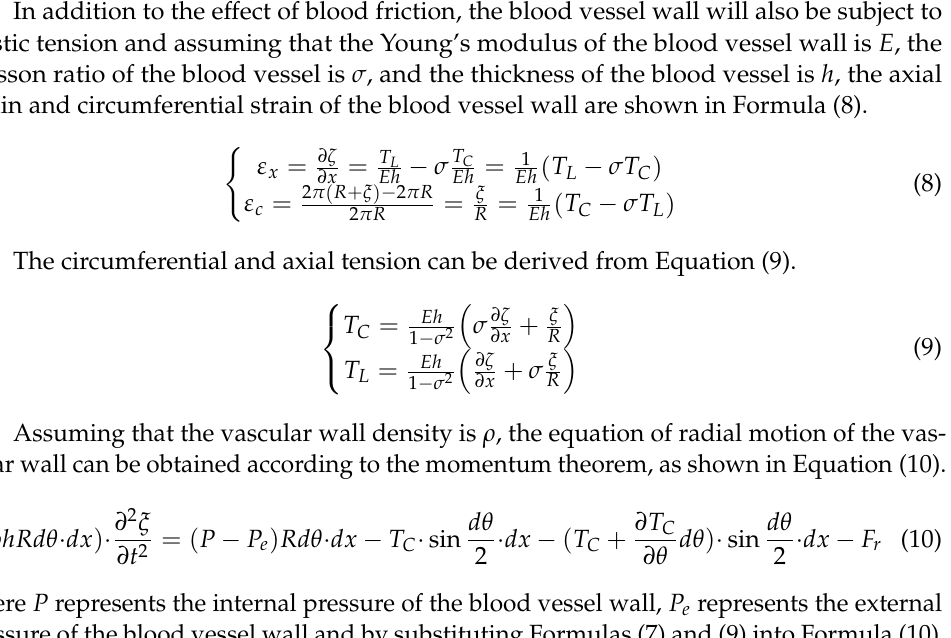
Therefore, the radial and axial components of the viscous friction force are shown in Equation (7).